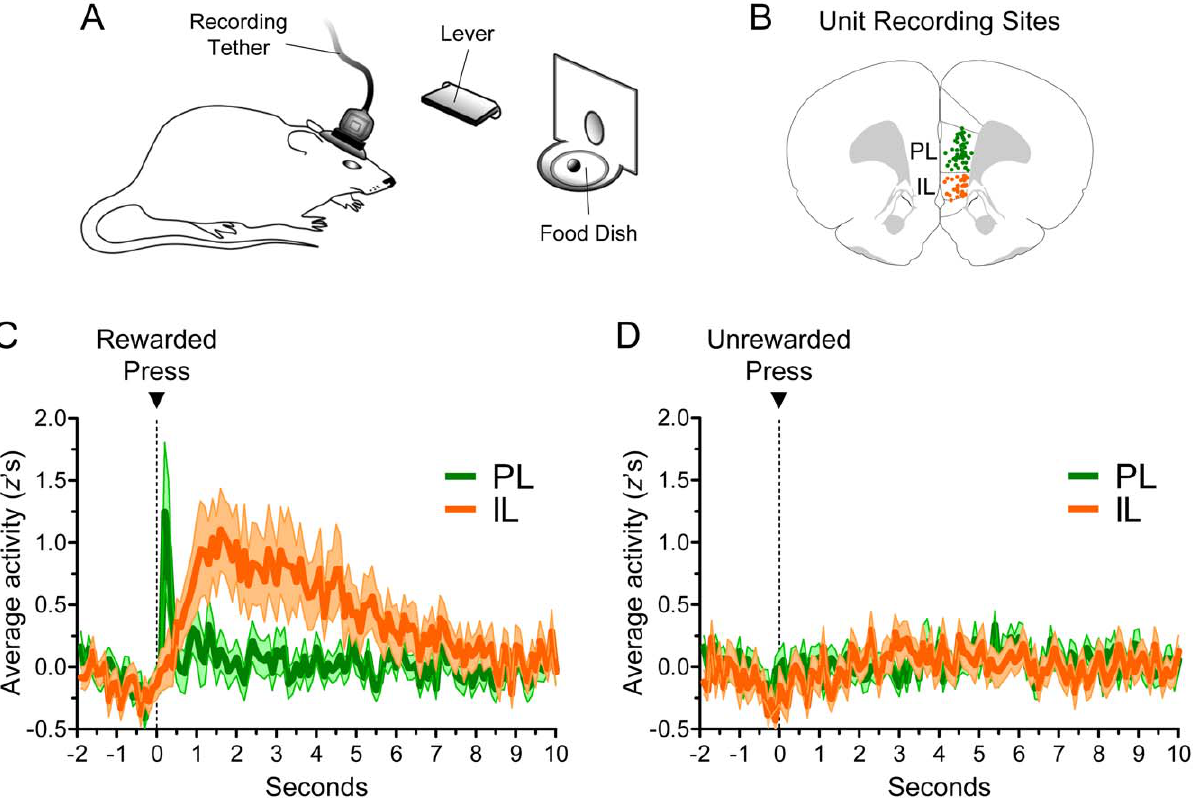
Figure 1. PL and IL exhibited temporally distinct reward responses. A, Neuronal activity was recorded from PL or IL while rats pressed a lever for sucrose pellets on a variable interval schedule of reinforcement of 60 seconds (VI-60). The lever and food dish were 6 cm apart from each other, and a rewarded press resulted in only one sucrose pellet. B, Coronal reconstruction of recording sites (bregma + 2.80 mm). Dots represent the position of electrode tips, and activity was recorded from a total of 244 neurons from 28 rats (PL: n =134, IL: n =110). C, Average normalized response of PL and IL during rewarded presses ( all recorded neurons included ). PL exhibited a fast and transient response that lasted for a few hundred milliseconds, whereas IL exhibited a response of longer latency that lasted for several seconds. D, Neither structure responded during unrewarded presses. [Data is illustrated as z -scores, in 100-ms bins. Error in all figures represents SEM.].